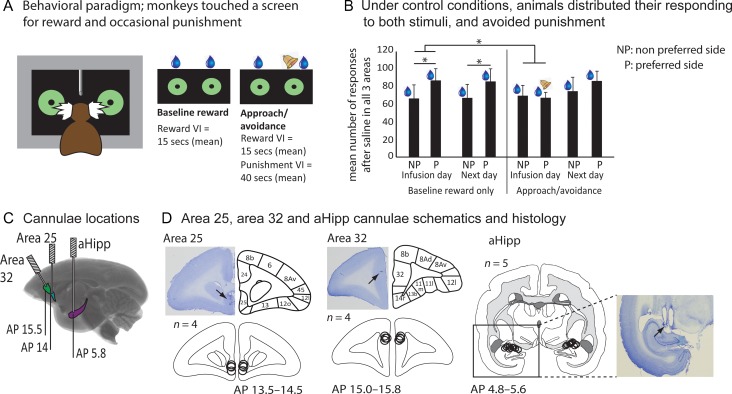
Approach–avoidance paradigm and prefrontal cannulae placements. (A) Marmosets were presented with two identical visual stimuli presented to the left and right of a touch-sensitive computer screen. Touching either stimulus earned reward (5 s banana milkshake; blue drop) according to independent but identical reward schedules. Occasionally and in addition to the reward schedule, responding to one of the stimuli also earned a punishment (0.3 s 117 dB mildly aversive loud noise; bell) on a leaner independent variable interval schedule. (B) Under control conditions marmosets responded relatively equally to both stimuli, with a slight preference to their preferred side (P). Accordingly there is more responding to the preferred/to-be-punished side than the nonpreferred (NP)/nonpunished side under baseline conditions that is seen on both the infusion day and the day after (infusion day, t4 = 3.5, P = 0.024; next day, t4 = 3.03, P = 0.038). This bias was abolished when punishment was introduced on the preferred side as animals biased away from the punishment, towards the nonpreferred/nonpunished side. However, the day after the punishment/saline infusion, the preferential responding to the preferred side returned, and did not differ from equivalent baseline performance (F1,4 = 2.58, P = 0.18). Data represent mean number of responses after saline infusion into the aHipp and areas 25 and 32 ± standard error of the mean (SEM) (n = 5). *P < 0.05. (C) Sagittal marmoset MRI section illustrating the rostrocaudal targets of area 25, area 32, and aHipp infusions. (D) Schematics showing the intracerebral cannulae targeting area 25, area 32, and the aHipp (in the PFC areas, the double cannulae straddled the midline resulting in each unilateral area receiving a single cannula), the actual cannulae locations for each animal and representative histological sections with arrows marking the position of the cannulae. All cannulae are plotted onto a single coronal section for each target area and the AP range indicated. Cytoarchitectonic parcellation is according to Burman and Rosa (2009) and the circles represent the estimated maximal spread of the muscimol/baclofen or saline infusions (West et al. 2011).